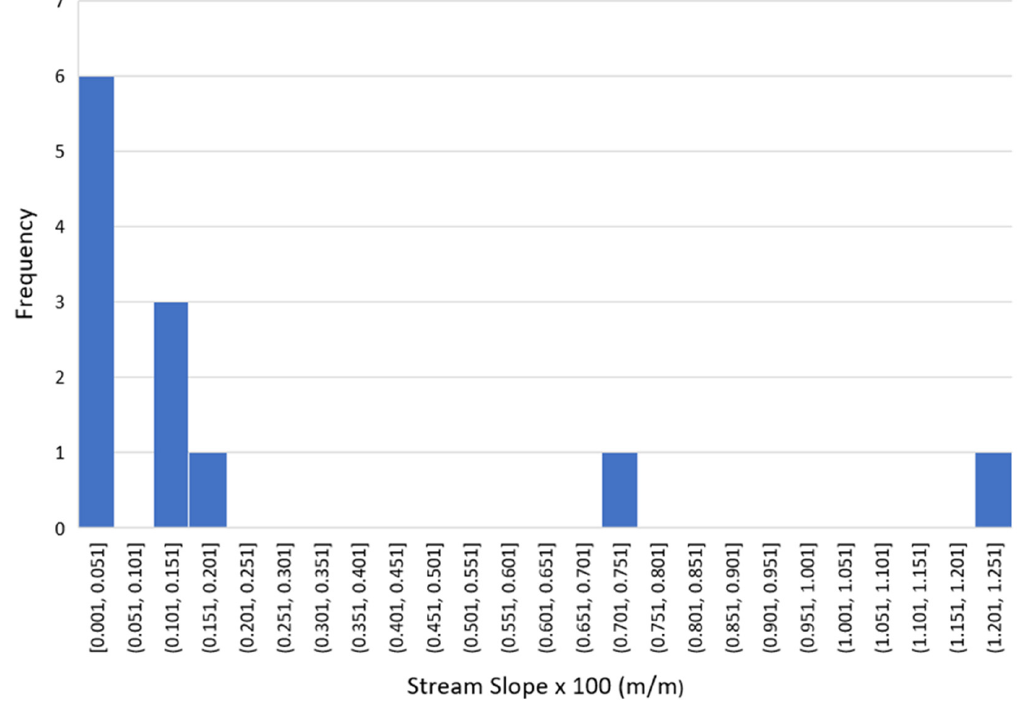
Figure A4. Stream slope at low head dams in Indiana with fatalities recorded.